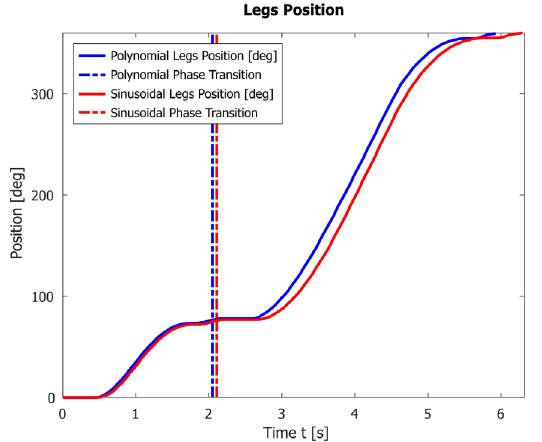
Figure 11. A comparison of the legs’ positions when using polynomial and sinusoidal law. A video with some of the experiments is available at the following link: https://youtu.be/zo1276JLs0k accessed on 20 January 2023.